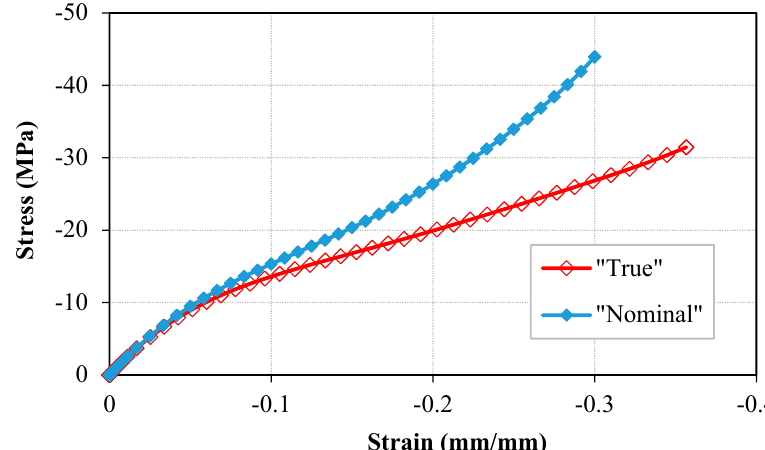
Figure 10. The true stress–strain curves obtained from the structural response of the model using di ff erent hyperelastic equations.